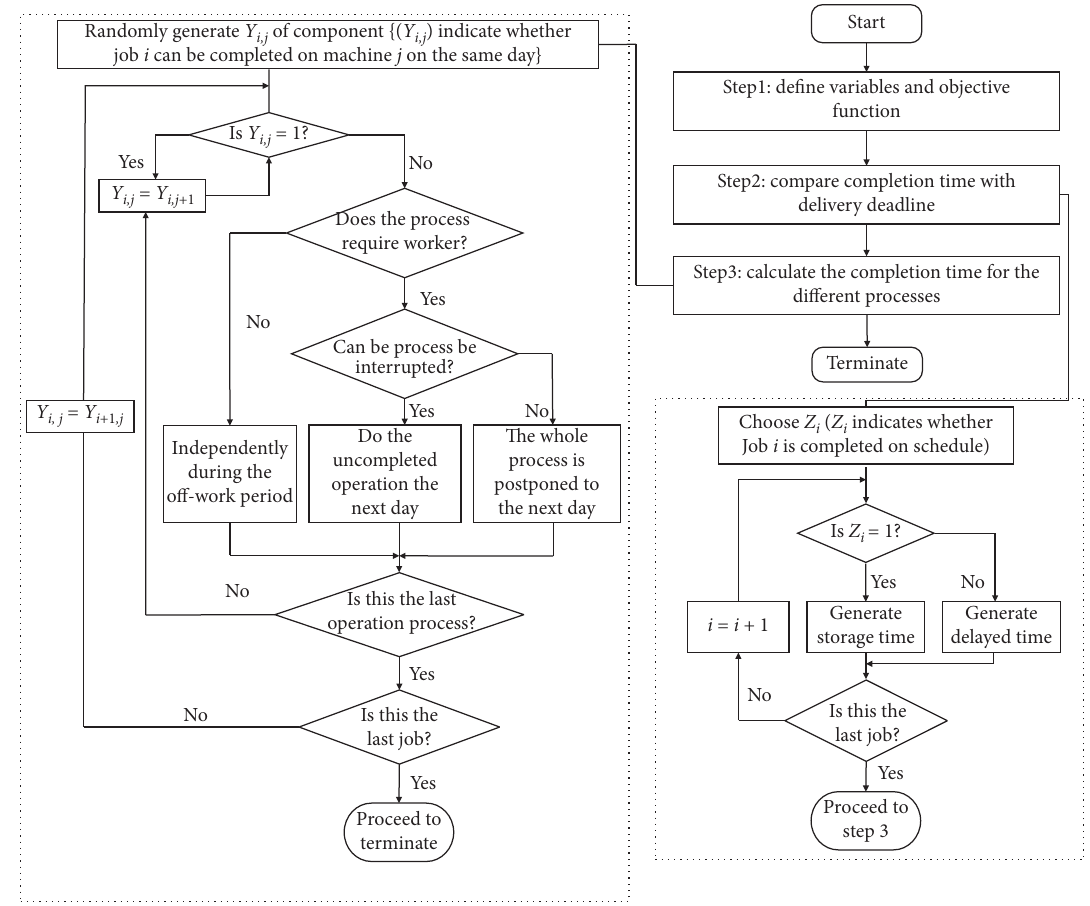
Figure 3: Algorithm